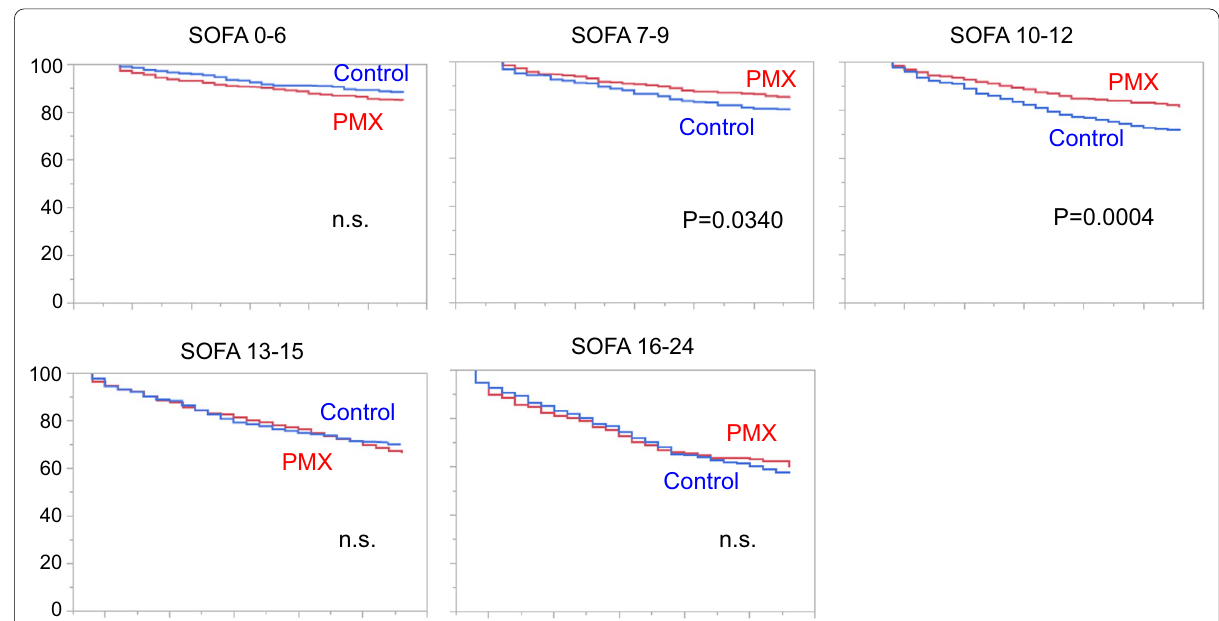
Fig. 2 Kaplan–Meier survival plots for patients treated with or without PMX in propensity score-matched cohorts. Patients were stratified into five categories: SOFA score, 0–6, 7–9, 10–12, 13–15, and 16–24. Then, we compared the survival curves in each